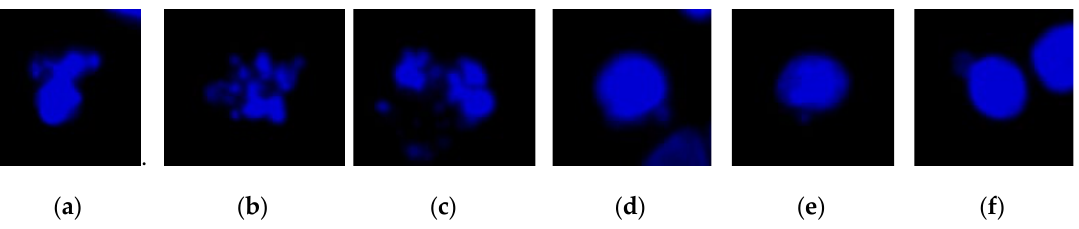
Figure 2. Cell nuclei images: ( a , b , c ) image of the cell nucleus with mitotic defects; ( d , e , f ) image of the cell nucleus with the micronucleus.